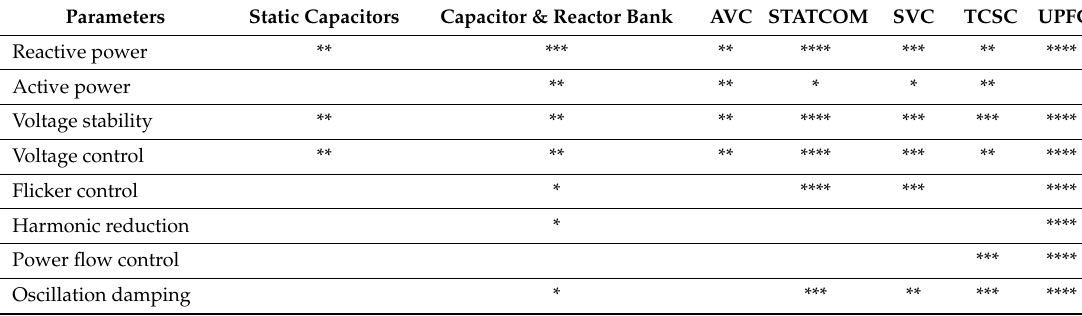
Table 3. Comparison of control parameters affected by reactive power-compensating devices.